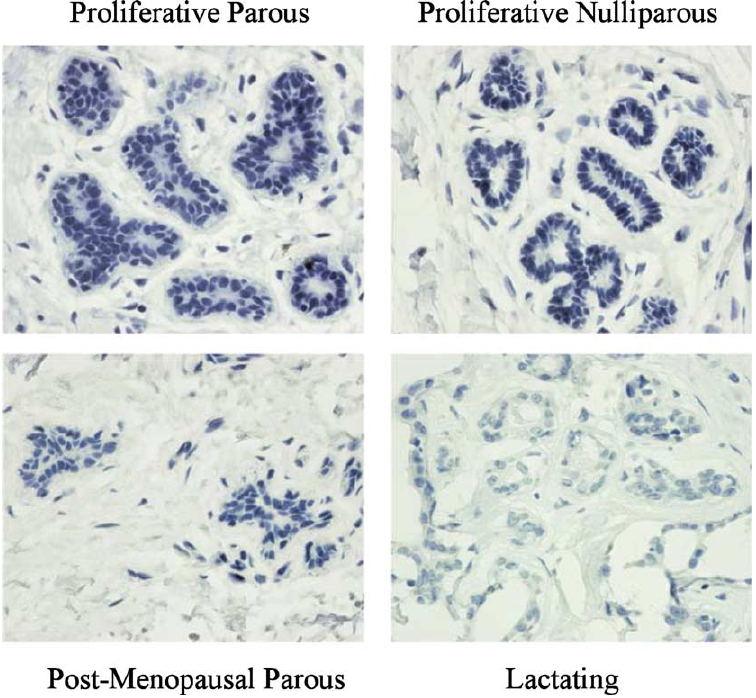
Fig. 1. Immunohistochemical detection of HOXA5 during the different phases of the reproductive history of the women. Representative photomi- crographs of sections of breast tissue stained with a 1:250 dilution of polyclonal anti-HOXA5 antibody. Paraffin-embedded breast tissues from proliferative parous, proliferative nulliparous, post-menopausal parous and lactating stages are shown. As evident from the photo-micrograph, lactating breast cells have very light HOXA5 staining compared to the other stages.